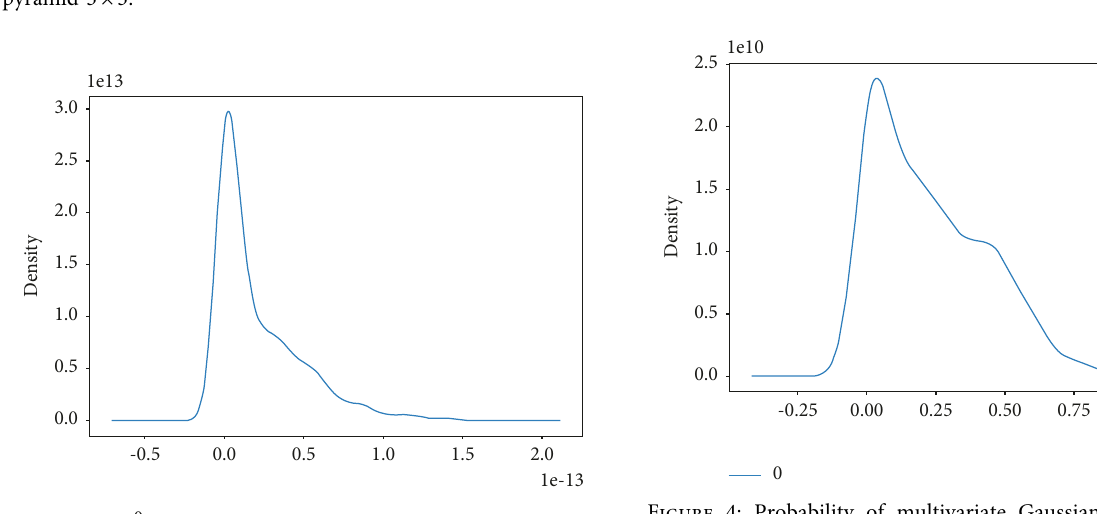
Figure 1: Probability of multivariate Gaussian with Gaussian pyramid 3 × 3.